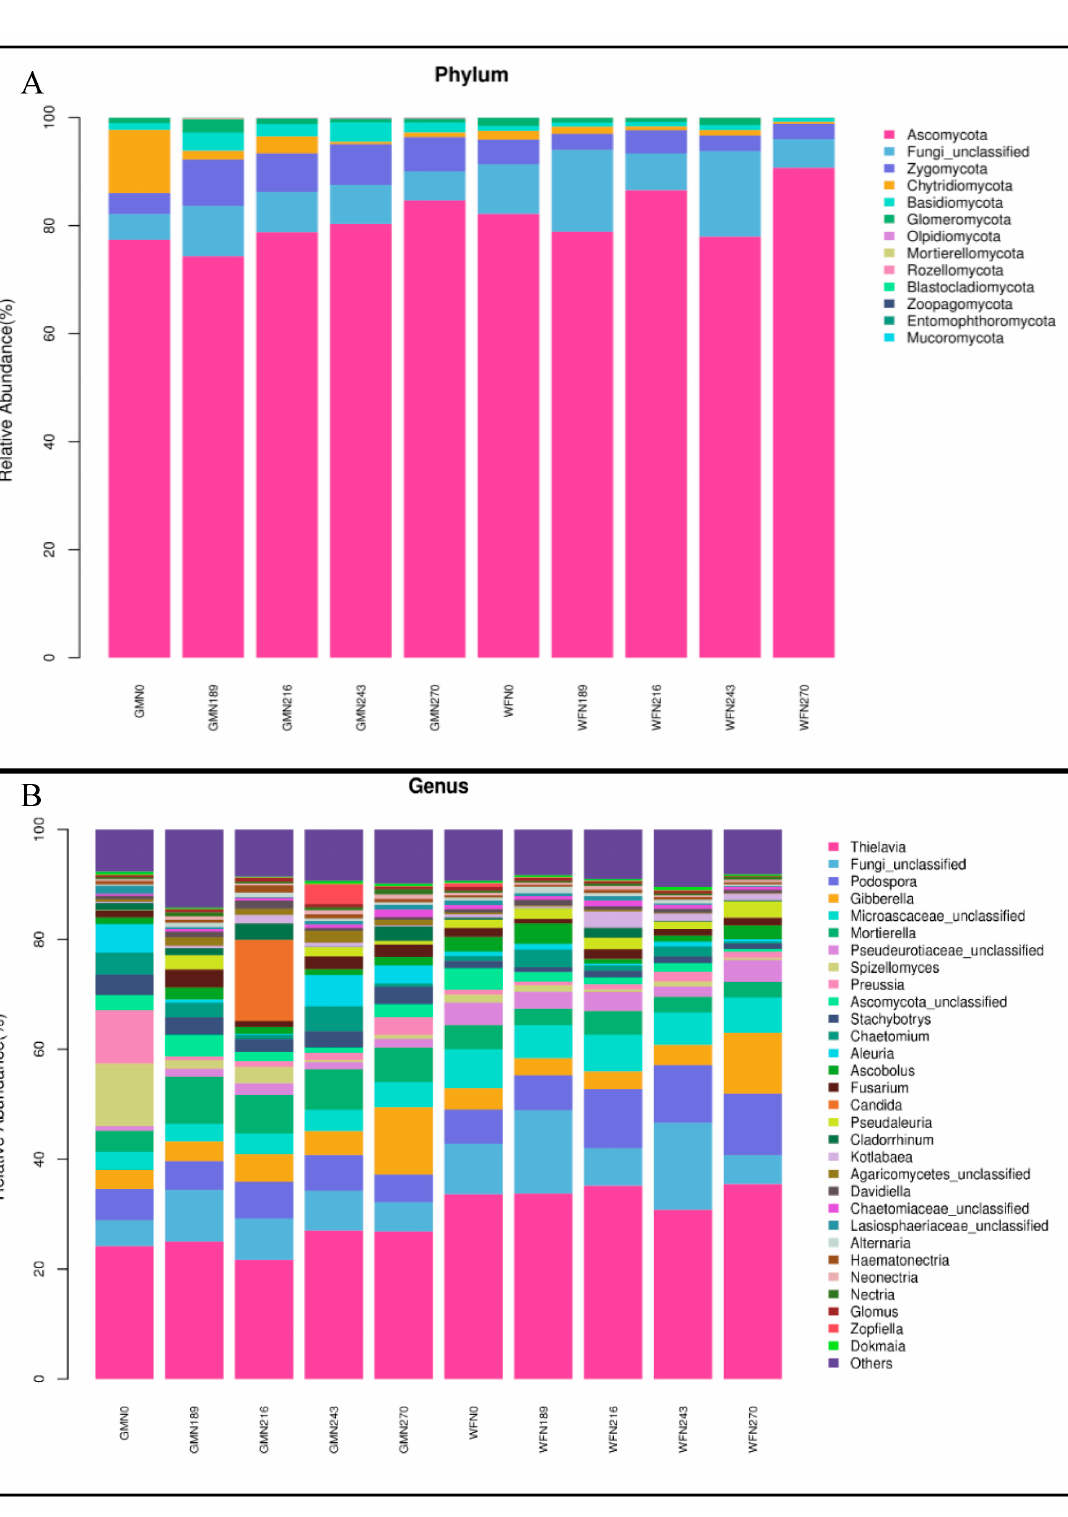
Figure 6. The soil fungal community’s response to N application under WF and GM treatments in the North China Plain. ( A ), Phylum level; ( B ), Genus level.